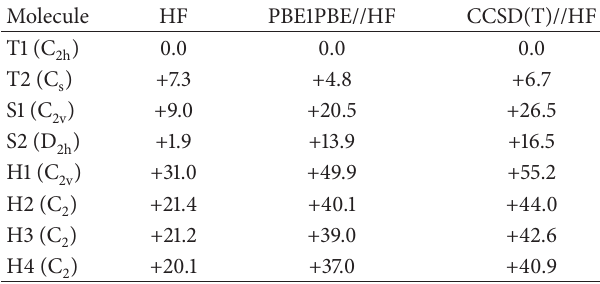
C isomers are shown in Figure 3. 18 6